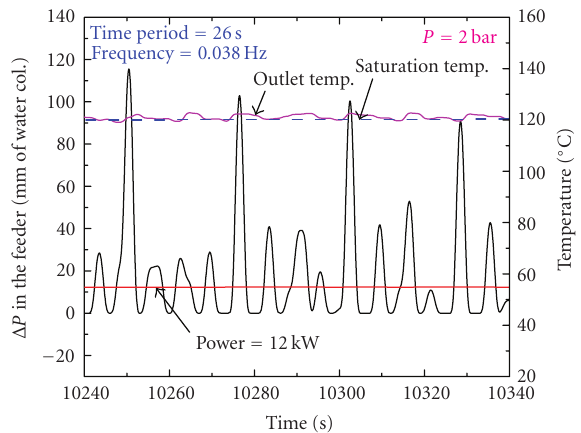
Figure 5: Typical flow instability behavior at low power under two- phase condition (initiation of boiling, power 12